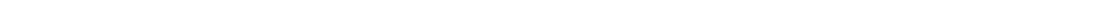
presented as the mean ± SEM. * P < 0.05, ** P < 0.01, *** P < 0.001, **** P < 0.0001. d Filopodia induction in cultured human podocytes was quanti fi ed